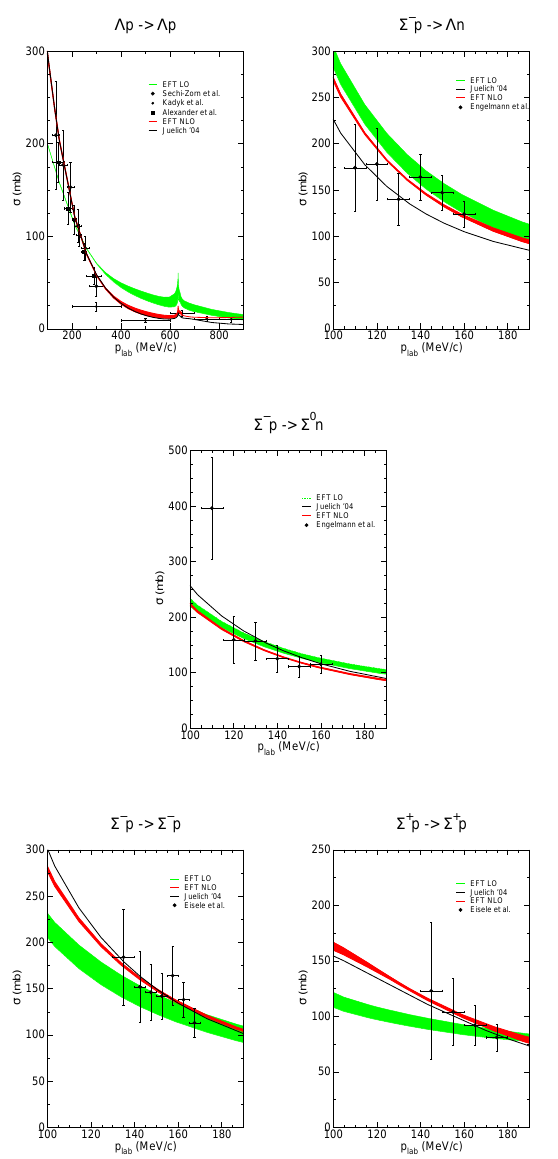
Λ p , Σ − p Λ n , Σ − p Fig. 9. Total cross sections for Λ p → → → Σ 0 n , Σ − p Σ − p and Σ + p Σ + p as a function of p lab . The → → green (grey) band shows the chiral EFT results to LO for varia- tions of the cut-o ff in the range Λ = 550 . .. 700 MeV, while the red (black) band are preliminary results to NLO. The solid curve is the result of the J¨ulich ’04 [21] meson-exchange